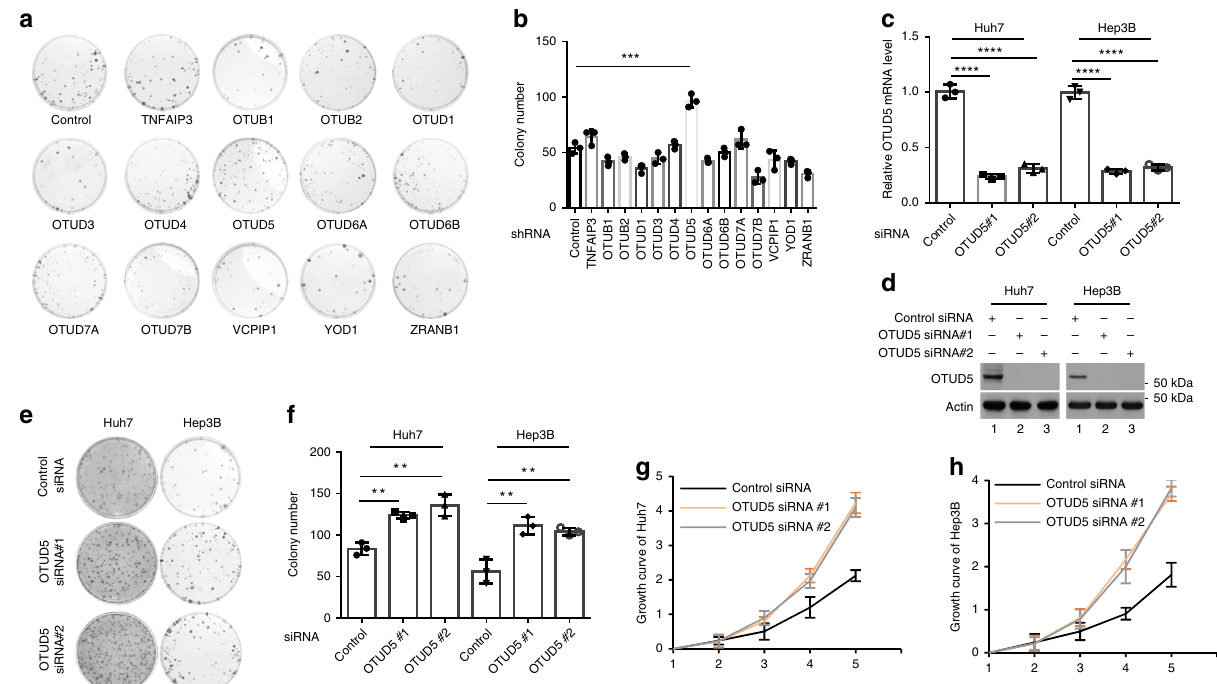
Fig. 1 OTUD5 knockdown accelerated cell growth. a The indicated DUBs were depleted by shRNA in Hep3B cells. DUB-depleted Hep3B cells were cultured for 10 days. The colonies were visualized by staining with methylene blue. b Quantitation of the colonies shown in a . Data are presented as the means ± SD of three biological experiments. *** p = 0.0007 (shControl versus shOTUD5), two-tailed unpaired t -test. c The mRNA level of OTUD5 in the OTUD5-depleted and negative control cell lines was determined by RT-PCR. GAPDH served as an endogenous control. Data are represented as means ± SD from three biological experiments. **** p < 0.0001 (siControl versus siOTUD5 #1 in the Huh7 cells), **** p < 0.0001 (siControl versus siOTUD5 #2 in the Huh7 cells), **** p < 0.0001 (siControl versus siOTUD5 #1 in the Hep3B cells), **** p < 0.0001 (siControl versus siOTUD5 #2 in the Hep3B cells), two- tailed unpaired t -test. d The protein expression of OTUD5 in the OTUD5-depleted and negative control cell lines was determined by western blot. β -actin served as a loading control. e Colony formation assay with the control cells or cells with OTUD5 depleted by one of the two different siRNAs. Cells were cultured for 10 days, transfected with siRNAs and stained by methylene blue. f Quantitation of the data shown in e from three repeated 35 mm dishes. Data are represented as means± SD. ** p = 0.0012 (siControl versus siOTUD5 #1 in the Huh7 cells), ** p = 0.0038 (siControl versus siOTUD5 #2 in the Huh7 cells), ** p = 0.0060 (siControl versus siOTUD5 #1 in the Hep3B cells), ** p = 0.0054 (siControl versus siOTUD5 #2 in the Hep3B cells), two-tailed unpaired t -test. g and h Growth curves of the OTUD5-depleted Huh7 cells ( g ) and Hep3B cells ( h ) as determined by spectrophotometer. Data are presented as the means ± SD of three independent experiments with each performed in triplicate. Source data are provided as a Source Data fi